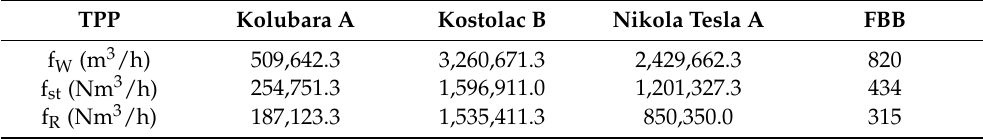
Table 1. Flue gas flows for TPPs and FBB under working conditions (f W ), under standard conditions and dry flue gas (f st ), and under standard conditions for dried flue gas and oxygen content of 6% (f R ). TPP Kolubara A Kostolac B Nikola Tesla A FBB f W (m 3 /h) 509,642.3 3,260,671.3 2,429,662.3 820 f st (Nm 3 /h) 254,751.3 1,596,911.0